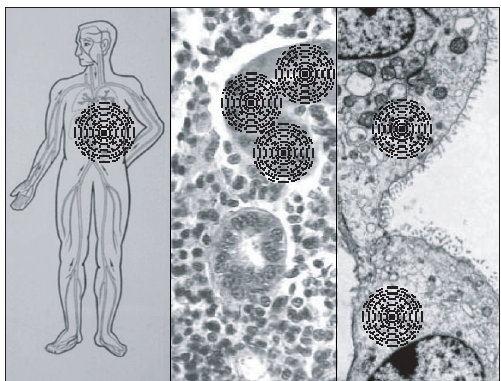
Figure 1: Three levels of targeting: preferably, siRNA should be tar- geted to the diseased tissue (I). Within this tissue it should be deliv- ered to the correct cell type for silencing the mRNA of interest (II). Following entry of the target cell, siRNA should be delivered to the cytoplasm (and/or nucleus) to interact with the components of the RNAi machinery